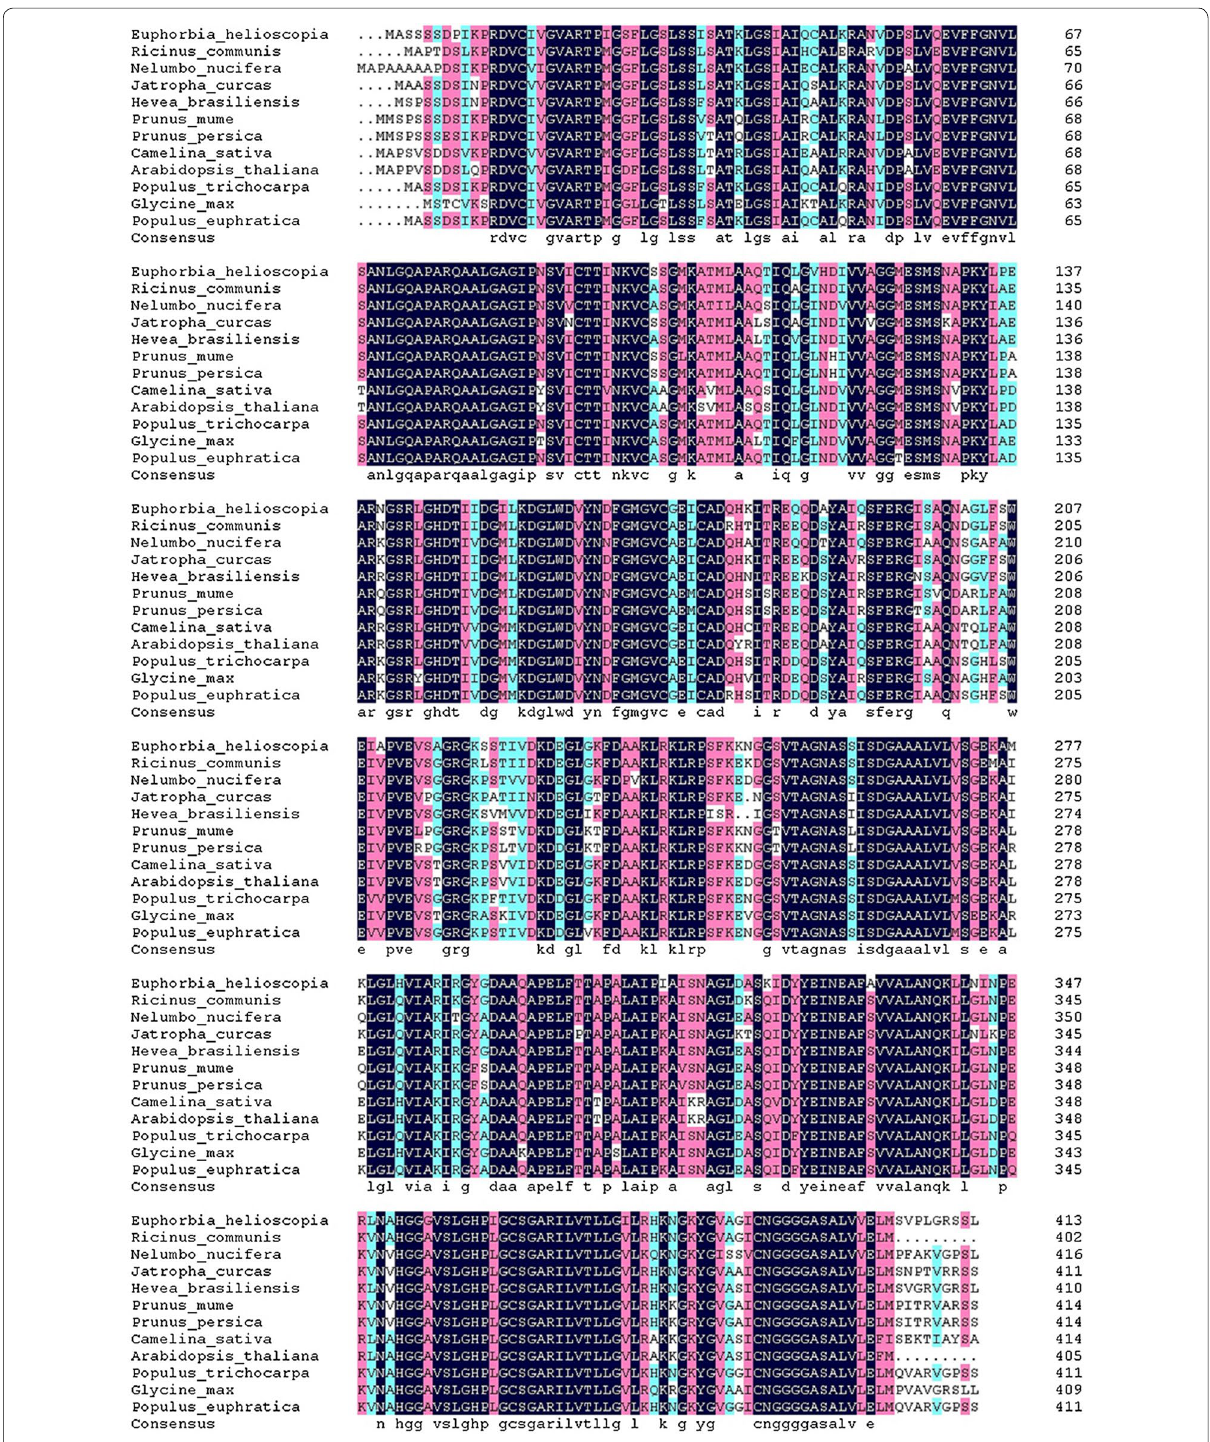
Fig. 2 Multiple sequence alignment of deduced EhAACT with those of other species. Blue shading means 100% sequence identity, pink shading means more than 75% sequence identity, light blue means more than 50% sequence identity; underline means specific domain of